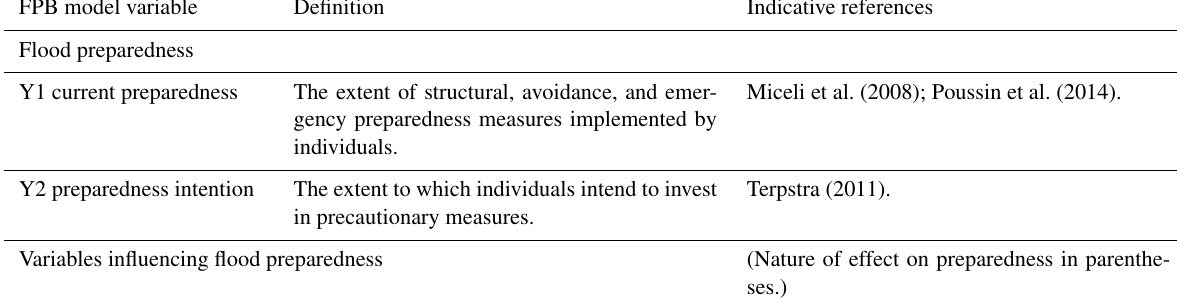
Table 1. Definitions of FPB model variables and indicative